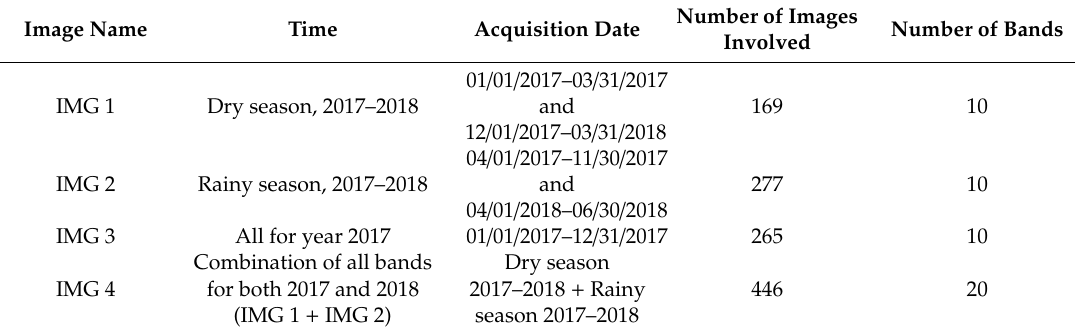
Table 2. Seasonal satellite images used in the